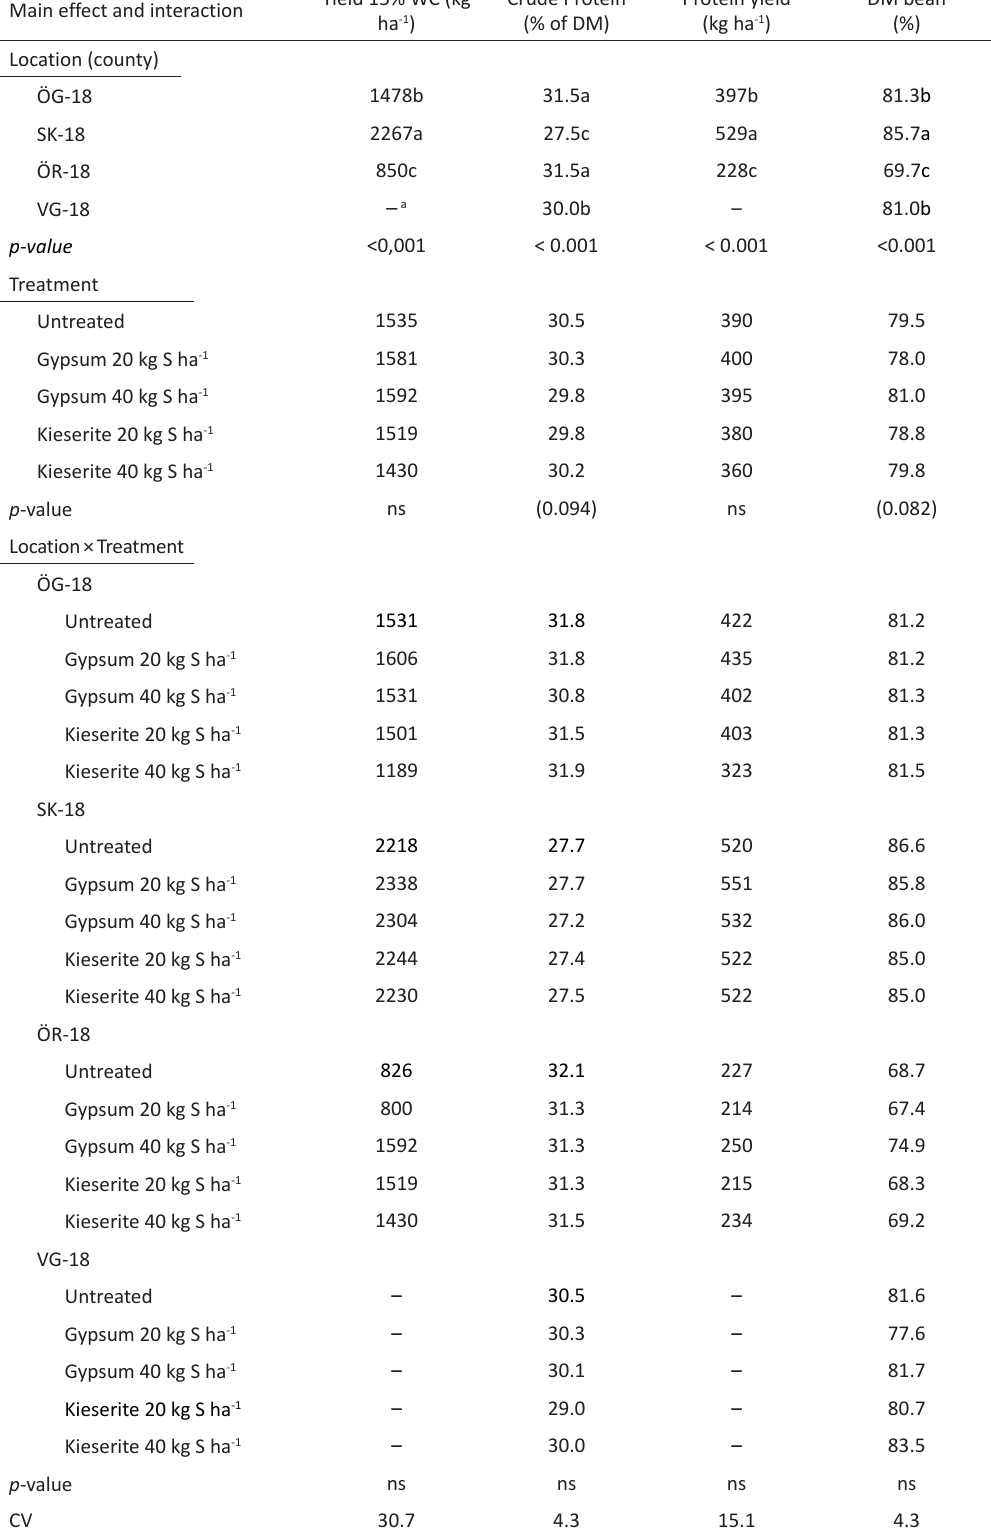
Table 7. Content of crude protein, protein yield and dry matter content (DM) of faba bean supplied with various sulphur applications in 2018 Main effect and